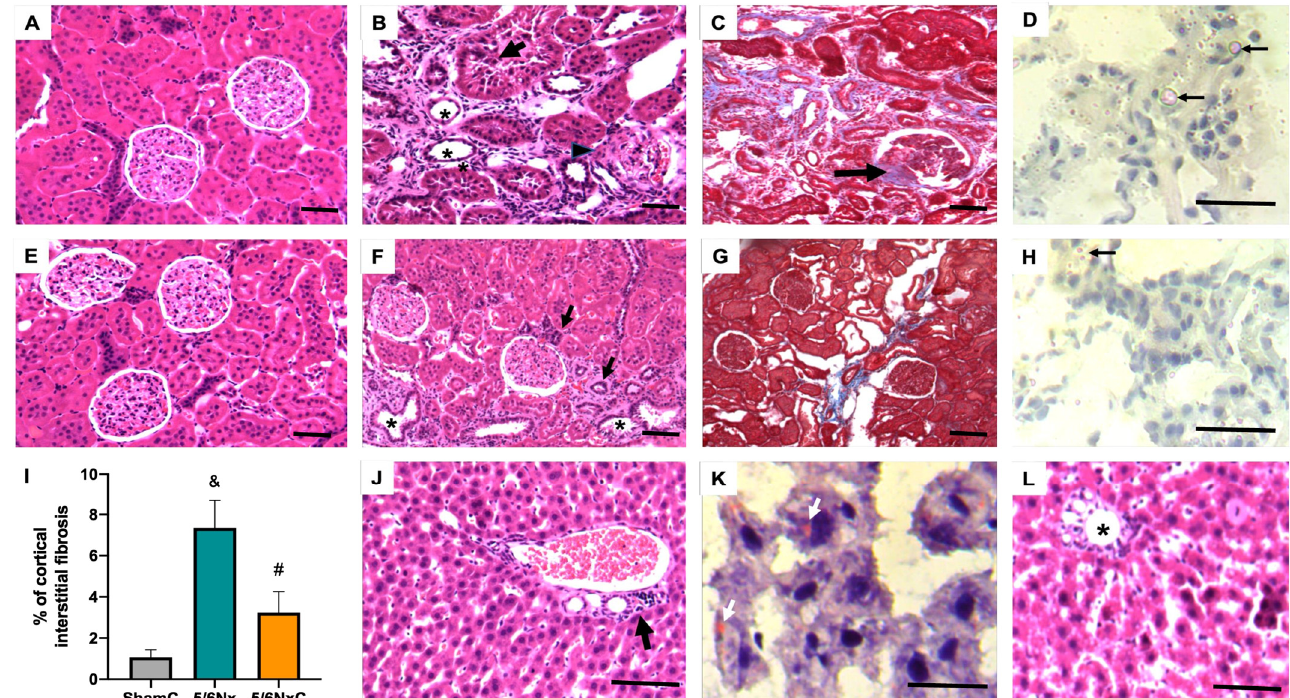
Figure 3. Representative micrographs from the four experimental groups: Sham, Sham + curcumin (ShamC), five-sixths nephrectomy (5/6Nx), and 5/6Nx + curcumin (5/6NxC). ( A ) Histologically normal kidney from Sham group rat. ( B ) In comparison, the 5/6Nx rat kidney shows interstitial fibrosis with chronic inflammatory infiltrate, tubules with atrophic (asterisks) or necrotic (arrow) epithelium, glomerulus with retracted capillaries, and vascular pole fibrosis (arrowhead). ( C ) Masson’s trichrome stain in 5/6Nx rat kidney shows more evident fibrosis, collagen stained blue, particularly in the interstitium and in the vascular pole of some glomeruli (arrow). ( D ) Oil red staining of the 5/6Nx group shows numerous cytoplasmic small red vacuoles in tubular cells that correspond to lipids; some tubules have big lipid drops in the tubular lumen (arrows). ( E ) Kidney section of a ShamC does not show histological alterations. ( F ) Treatment with curcumin in animals with 5/6Nx (5/6NxC group) induces a decrease in renal fibrosis and preservation of cortical tubules, some tubules show necrotic epithelium (asterisks), and others are small and lined with cubic cells with hyperchromatic nuclei corresponding to cells in regeneration (arrows), the glomeruli do not show fibrosis or retraction of the capillaries. ( G ) Masson’s staining shows decreased interstitial fibrosis and glomerular affectation in the 5/6NxC rat kidney. ( H ) Oil red staining in 5/6NxC rat kidney shows some epithelial cells with occasional cytoplasmic lipid vacuoles (arrow). ( I ) The automated morphometric analysis showed a significant decrease in interstitial fibrosis in the 5/6NxC group compared to the 5/6Nx group. ( J ) Portal area of the 5/6Nx liver showing chronic inflammatory infiltrate (arrow). ( K ) Oil red staining shows some 5/6Nx hepatocytes with scare cytoplasmic lipid vacuoles (white arrows). ( L ) The portal areas (asterisk) of the 5/6NxC rat liver without inflammation, some hepatocytes show regenerative changes such as increased cell and nuclear size, hyperchromasia and binucleation. Kidney sections staining H/E and Masson 200 × magnification, liver micrographs H/E staining 400 × magnification, frozen sections red oil staining 1000 × magnification. Bars represent 100 µ in paraffin sections and 50 µ in frozen